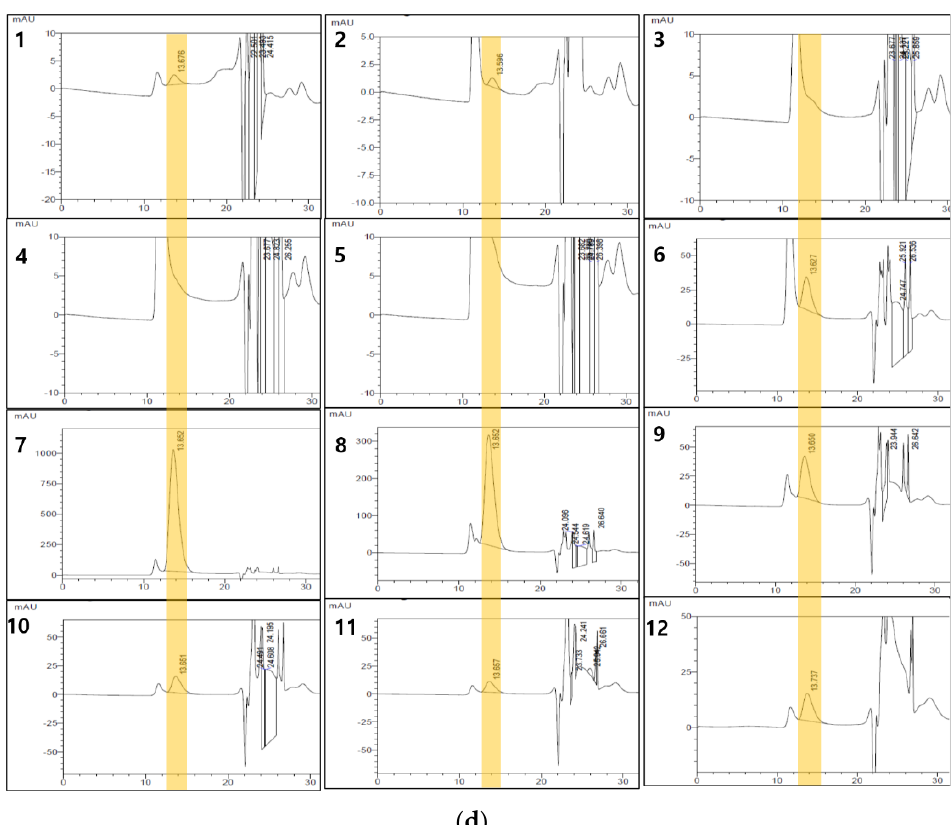
Figure 2. Wide dispersion of vaccine antigens by SDG fractionation. ( a ) An original chromatogram from SDG fractionation of SDG-purified FMDV O BE vaccine antigen. Numbers above the chart indicate each fraction number. ( b ) SDS-PAGE results of each SDG fraction from ( a ). FMDV O BE pure antigen was administered as a positive control. Between 24 and 31 kDa, bands of FMDV structural protein subunits are shown. ( c ) Western blot results of each SDG fraction from ( a ) using the VP1 antibody. VP1 bands were detected at approximately 31 kDa. ( d ) Original chromatograms from SE-HPLC of each SDG fraction from ( a ). Numbers in the top left of each chromatogram indicate each SDG fraction number injected into SE-HPLC. Yellow backgrounds indicate the detection time of the target peak. Abbreviations: SDG, sucrose density gradient ultracentrifugation; SE-HPLC, size-exclusion high-performance liquid chromatography.